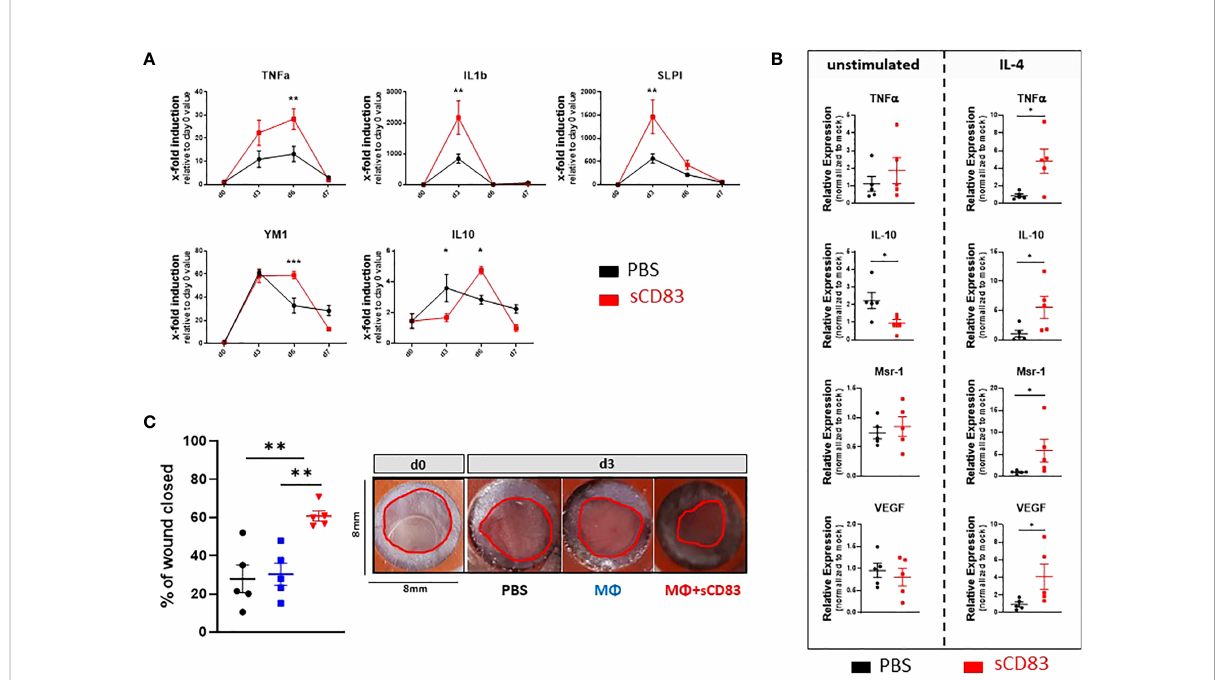
FIGURE 3 sCD83 promotes M F differentiation and activity in the course of wound healing. (A) Transcript analyses were performed with skin biopsies relatively to the day 0 value (each group and time point n ≥ 4). (B) RNA induction levels of Tnf a , Il-10, Msr-1 and Vegf were assessed in sCD83- treated M F under steady state conditions or in the presence of IL-4 (n=3) with the control group shown in black and sCD83-treated mice in red. (C) Ex vivo generated M F , cultured in the presence or absence of sCD83, were adoptively transferred into the wound beds and wound closure was assessed by caliper on day 3 relatively to the day 0 value (each n=5). Red circles highlight the wound area. (A) Two-way ANOVA. (B) Mann-Whitney test and (C) One-way ANOVA with F= 11,03. Asterisks mark statistically signi fi cant difference (* p< 0.05, **p < 0.01 and ***p < 0.001). The absence of asterisks indicates that there is no statistical signi fi